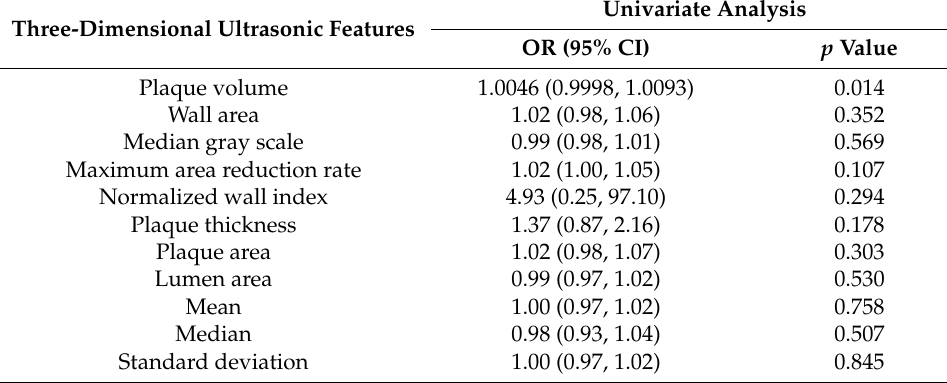
Table 3. Candidate predictors of three-dimensional ultrasound of carotid plaque after logistic regres- sion analysis.